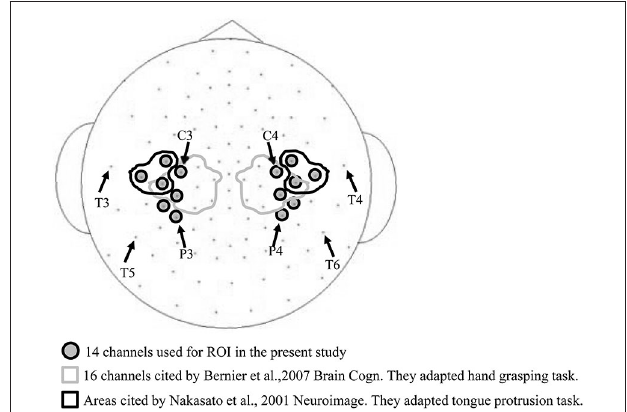
FIGURE 2 | Electrode channels used for the region of interest (ROI) . The 16 channels circled by the gray line were used to measure ERD/ERS in a hand grasping task (Bernier et al., 2007), and the six channels encircled by the black line in a tongue protrusion task (Nakasato et al., 2001). These arrays partially overlap with the 14 channels used in the current study (gray